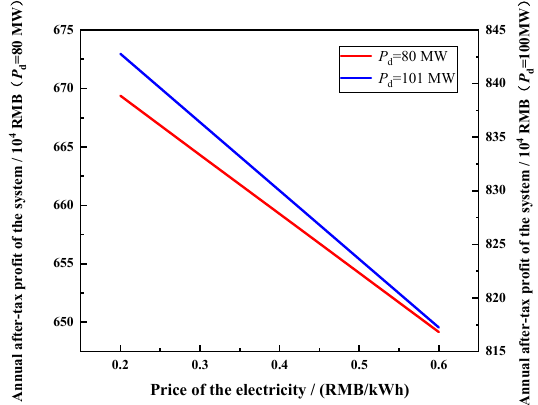
Figure 16. Annual after-tax profits vs. the price of the electricity.